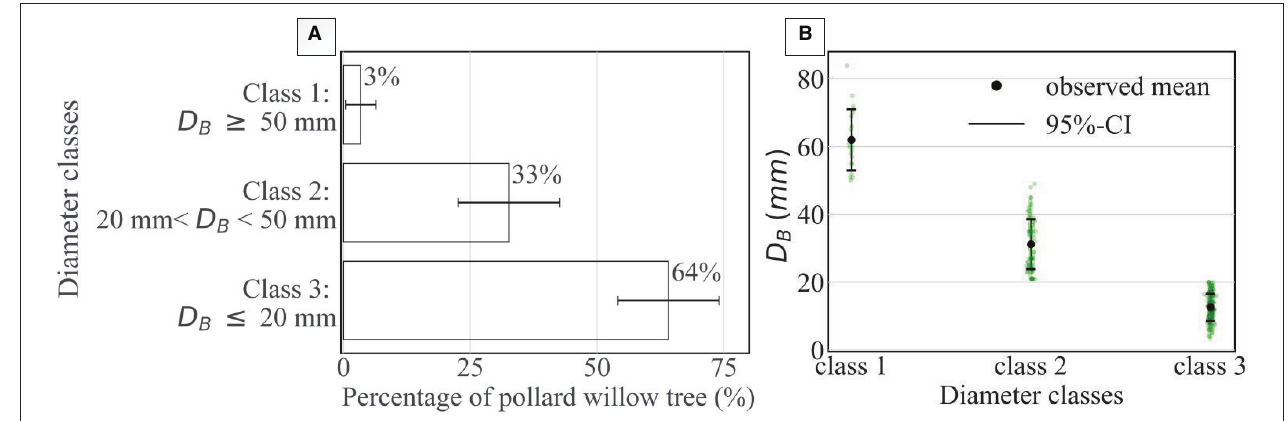
FIGURE 7 | (A) Distribution of diameter classes for a pollard willow tree, (B) diameter range found for each